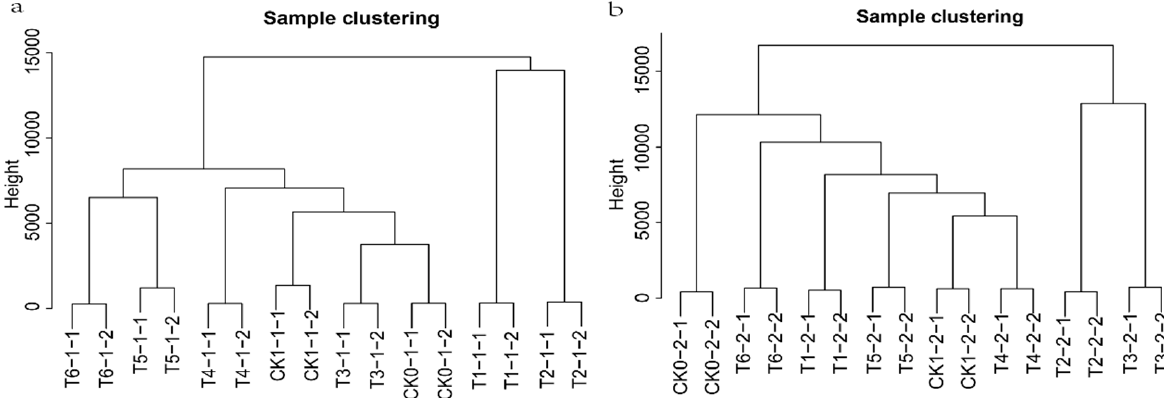
Figure 2. Sampling repeatability. ( a , b ) Hierarchical clustering tree showed that there are no outliers in root samples and in stem samples according to the expression of all genes.